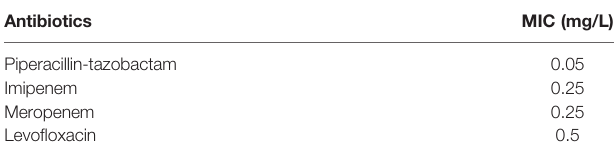
TABLE 1 | MIC results of H. huttiense .